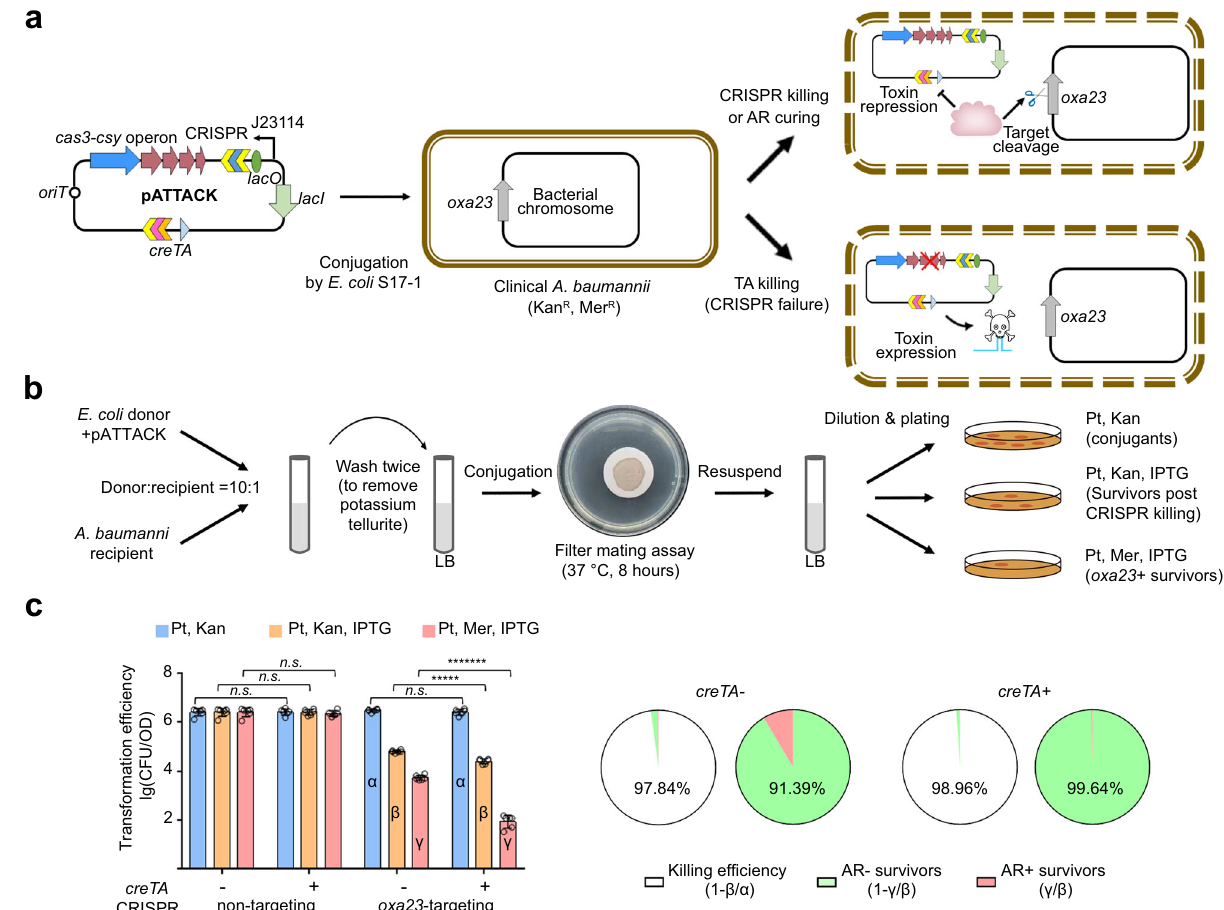
Fig.6|CreTAimprovedthekillingandcuringeffectsofCRISPRantimicrobials against an MDR A. baumannii clinical isolate. a Design of pATTACK. Note that the oxa23 -targeting CRISPR was controlled by a J23114 promoter with a lacO operator (repressed by LacI and induced by IPTG). oriT , the origin of conjugation transfer. b The fl ow chart of the conjugation assay to kill a clinical A. baumannii using pATTACK. c The bacteria killing and antibiotic resistance (AR) curing effects of CRISPR antimicrobial with or without creTA . Potassium tellurite (Pt) and kana- mycin (Kan, to kill E. coli donors) selected for all conjugants, Pt, Kan, and IPTG together selected for conjugants that survived from CRISPR targeting, while